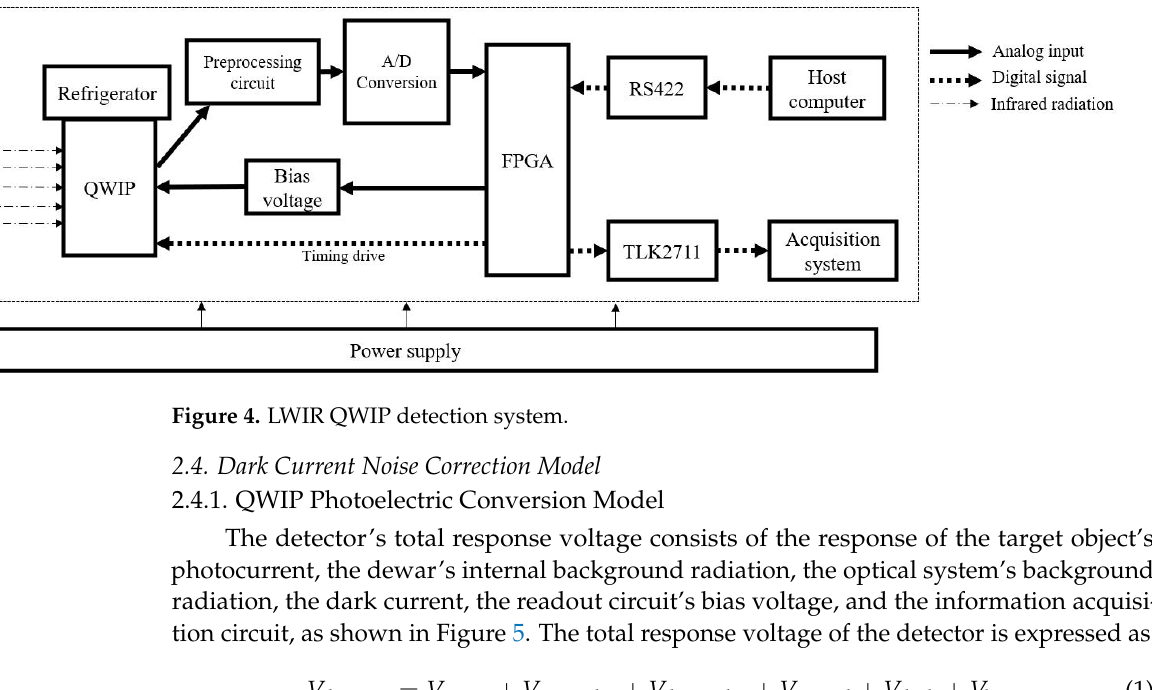
Figure 3. Fabrication of QWIP with dark pixels; ( a ) QWIP with dark pixels; ( b ) design schematic of QWIP with dark pixels.